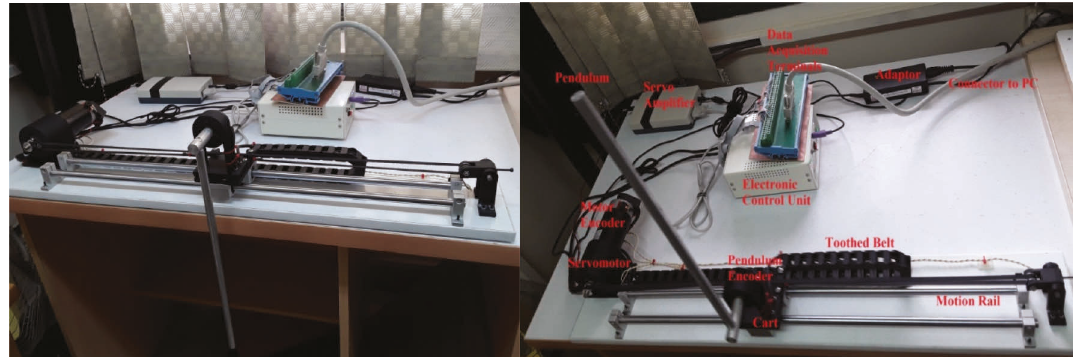
Figure 16: Configuration of the practical cart-pole system ((a) the pendulum in hanging mode, (b) the pendulum in inverted mode).